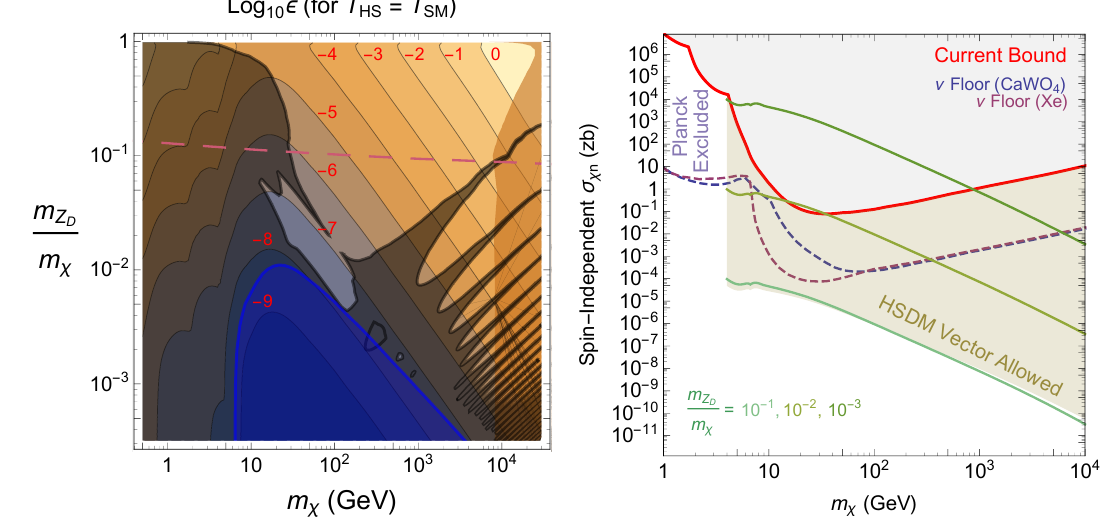
Figure 5 . Left: contours of the maximum allowed value of (cid:15) consistent with direct detection bounds in the HSFO-VP model. Within the shaded blue region, the two sectors were not in thermal equilibrium at freezeout. The combined region excluded by indirect detection constraints from (cid:12)gure 4 is shown by the black region. Above the dashed pink line is where Z D is non-relativistic at the freezeout temperature ( m Z =T f > 2 : 46). The brown region on the right of the plot illustrates D where the freezeout coupling as determined with and without Sommerfeld enhancement deviates by more than a factor of two (B.7). Right: the tan region shows the direct detection parameter space for WIMPs next door in the HSFO-VP model. At low dark matter masses, Planck excludes all dark vector masses and couplings. Shown in green are three speci(cid:12)c lower bounds on the direct detection cross section for the mass ratios m Z =m (cid:31) = 10 (cid:0) 1 ; 10 (cid:0) 2 , and 10 (cid:0) 3 . We also show the neutrino (cid:13)oor D for xenon and CaWO 4 (used in CRESST) with dashed purple and blue lines,